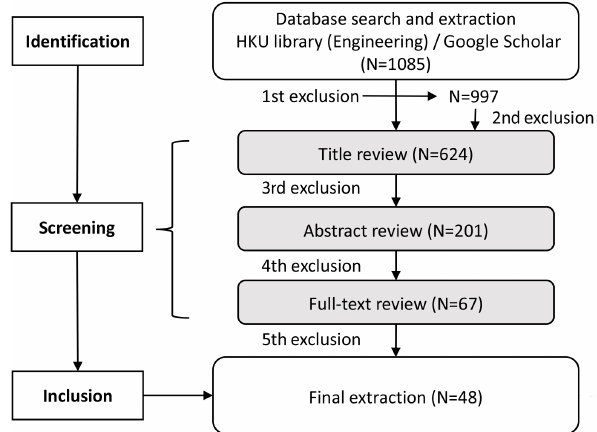
Figure 2. Preferred Reporting Items for Systematic Reviews and Meta-Analyses (PRISMA) framework showing the literature screening process.